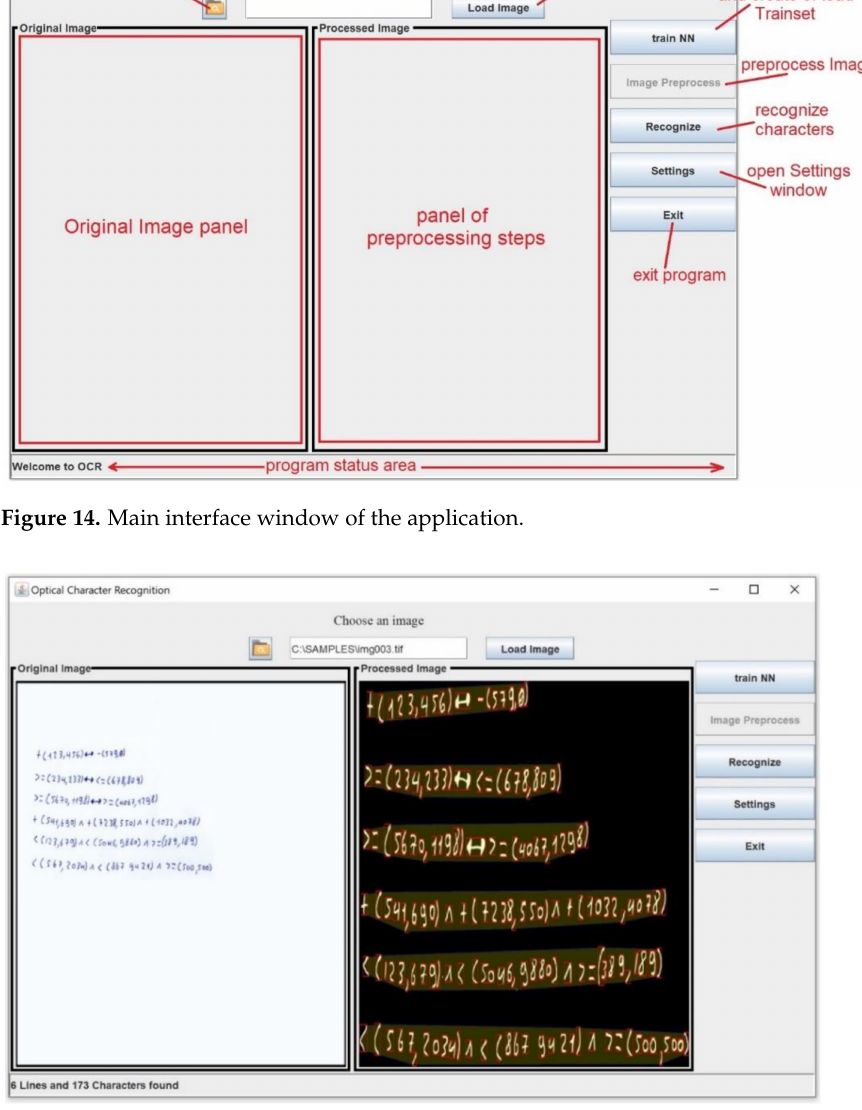
Figure 15. Main window instance of the final preprocessing